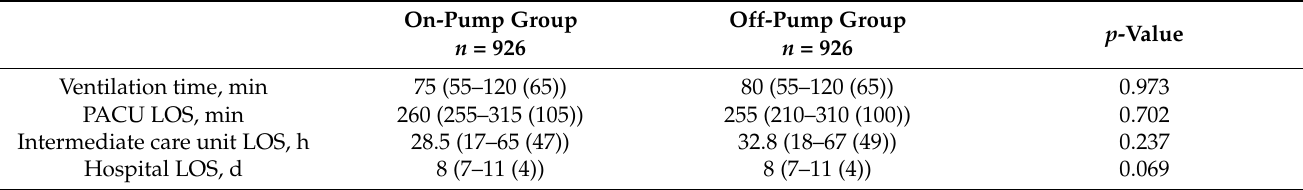
Table 2. Postoperative outcome parameters for patients included in the study. Values are median (IQR (range)).